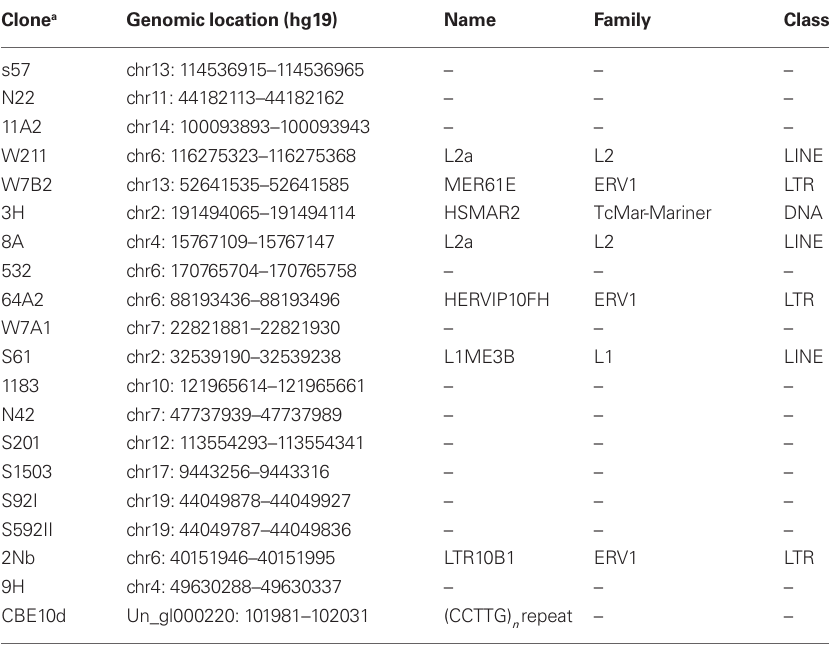
Table 1 | Characterization of 20 sequences reported by el-Deiry et al. (1992). Clone a Genomic location